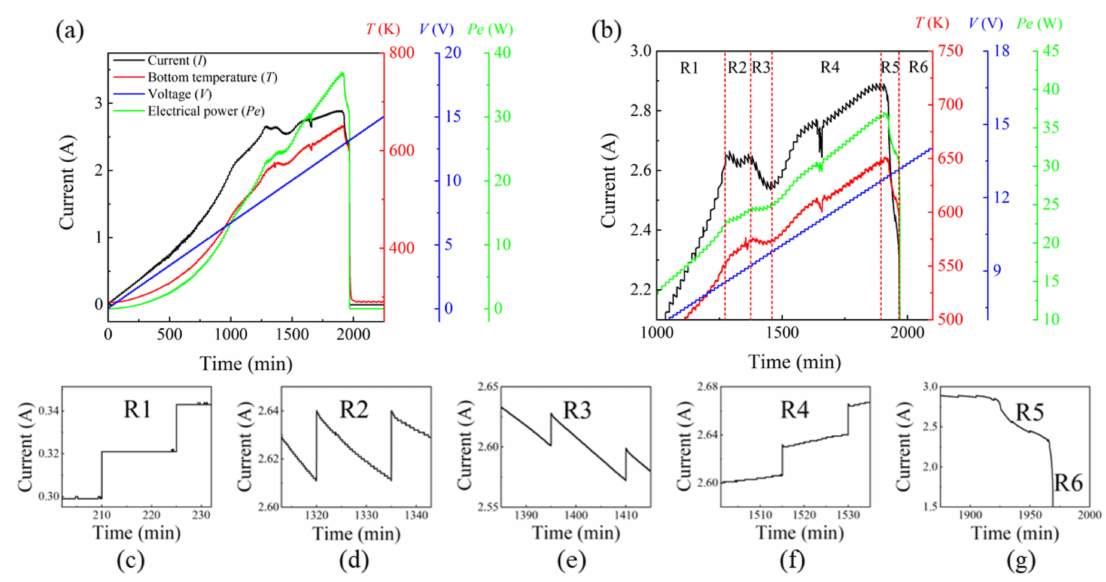
Figure 7. ( a ) The failure test of a typical integrated LMM thermal emitter. ( b ) An enlarged view of the failure process, which is divided into six regions denoted by R1–R6. ( c – g ) The enlarged views of the current evolution in each